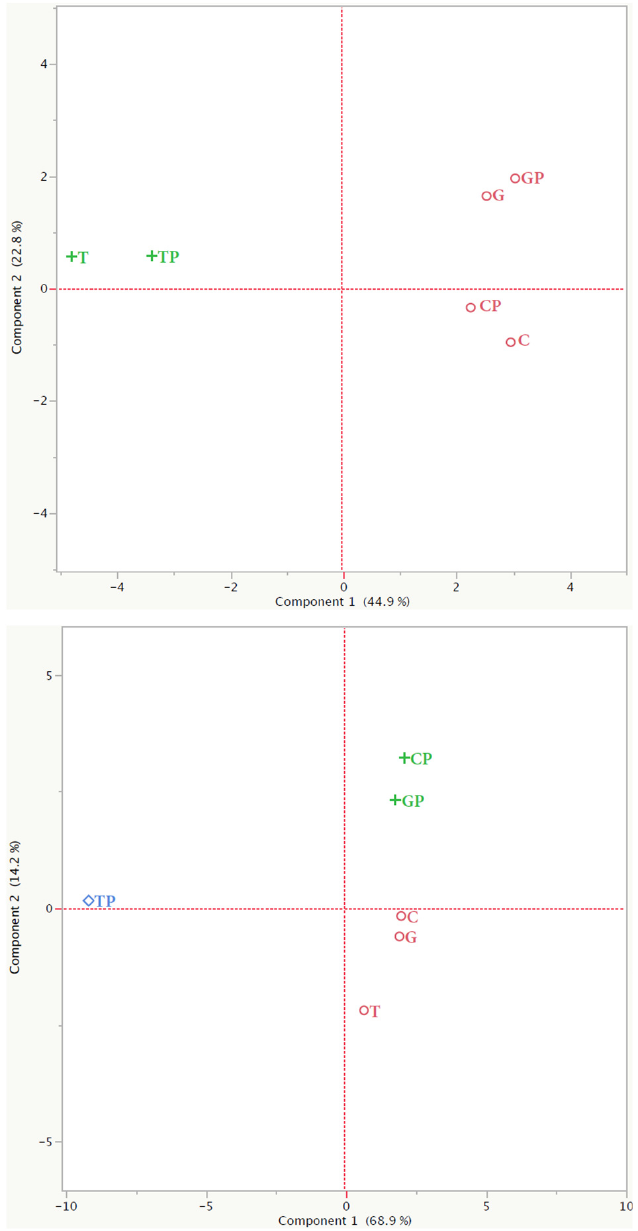
the two different protocols analysed at racking and at ends of